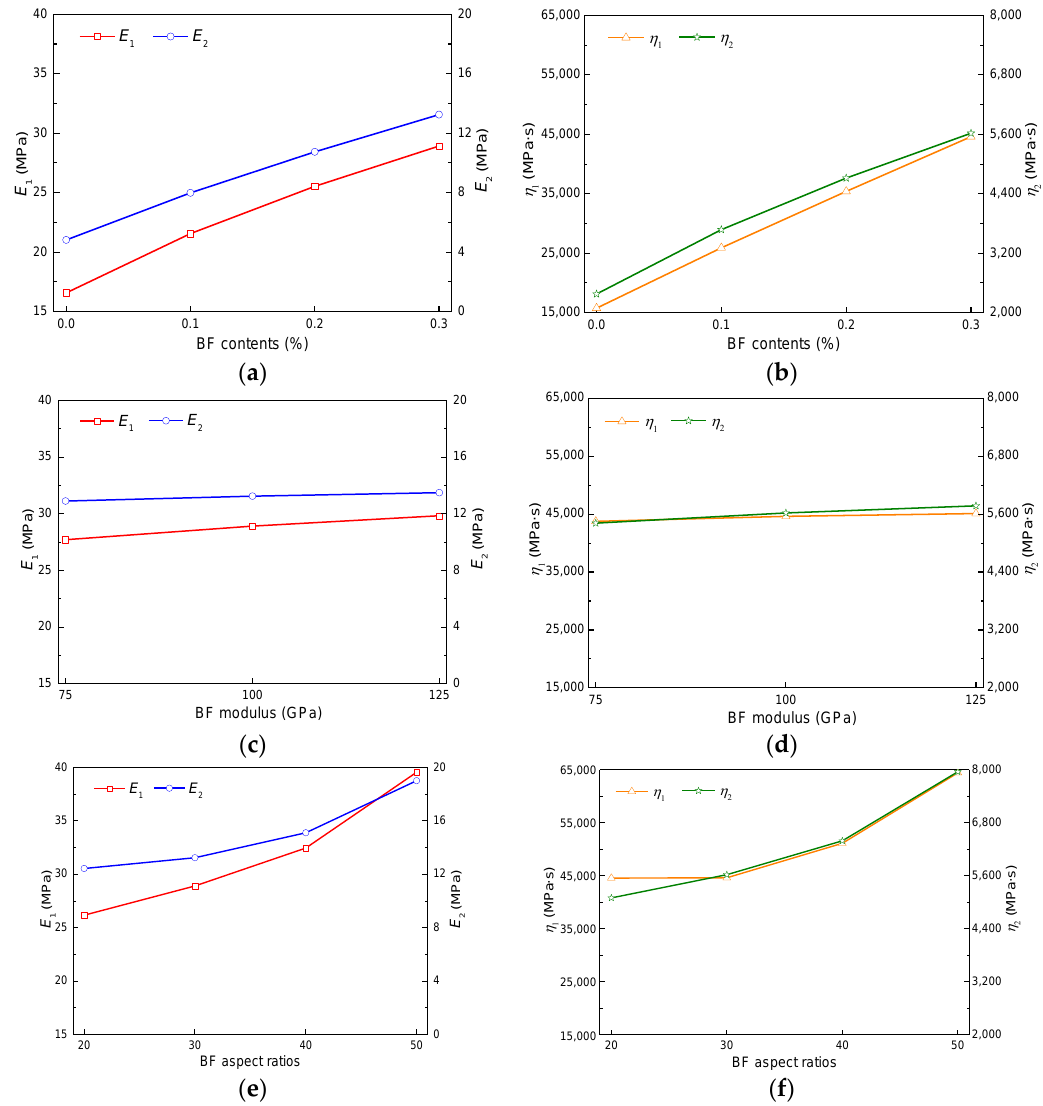
Figure 18. Relationship of BF factors to viscoelastic parameters for FRAM as: ( a ) E 1 and E 2 ; ( b ) η 1 and η 2 ; ( c ) E 1 and E 2 ; ( d ) η 1 and η 2 ; ( e ) E 1 and E 2 ; ( f ) η 1 and η 2 .